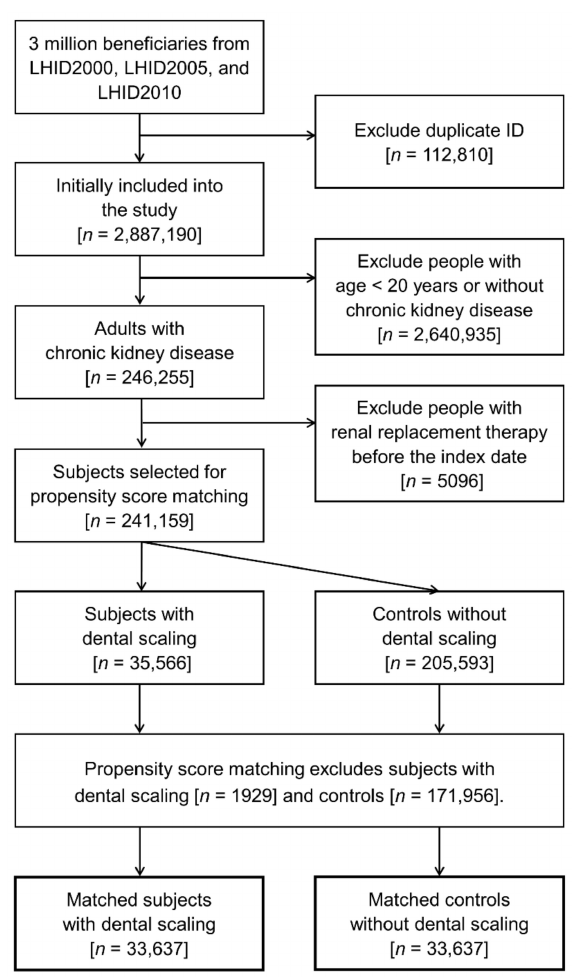
Figure 1. Flow diagram for patient